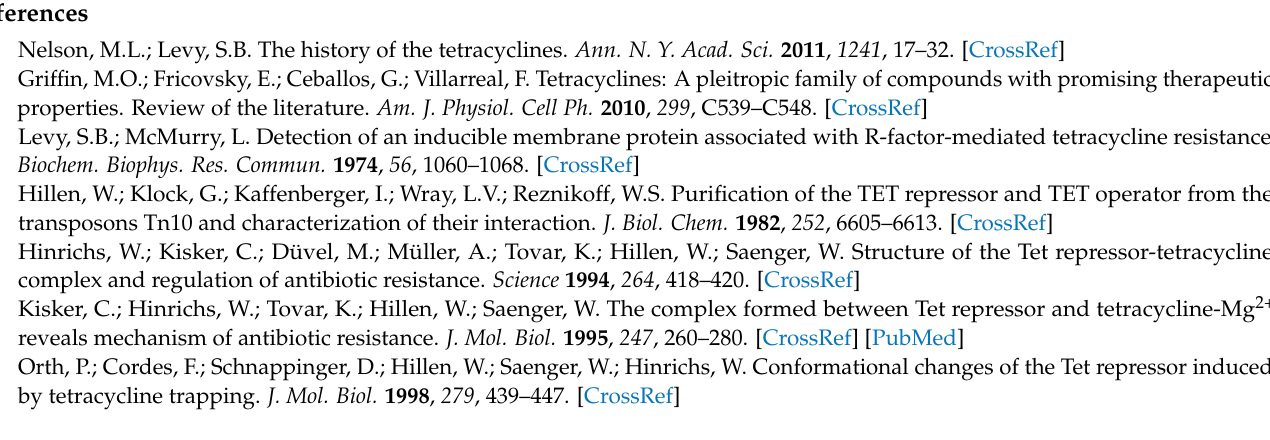
TetR; Table S2: Affinity parameters of the natural TetR and the mutant for TCs; Figure S1: The mass spectrometry results of the nine peptides; Figure S2: Amino acid sequences of the natural TetR and the TetR of other bacteria; Figure S3: Docking complexes with other TCs; Figure S4: Results for optimization of the assay